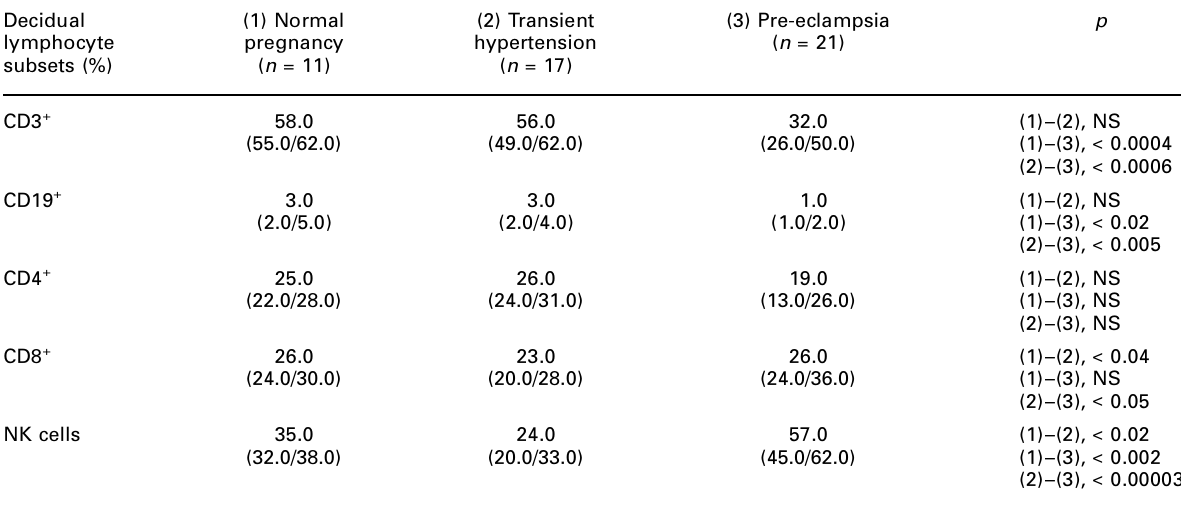
Table 2. The percentage of main decidual lymphocyte subsets in the group of healthy pregnant women, and pregnant patients with transient hypertension and pre-eclampsia Decidual lymphocyte